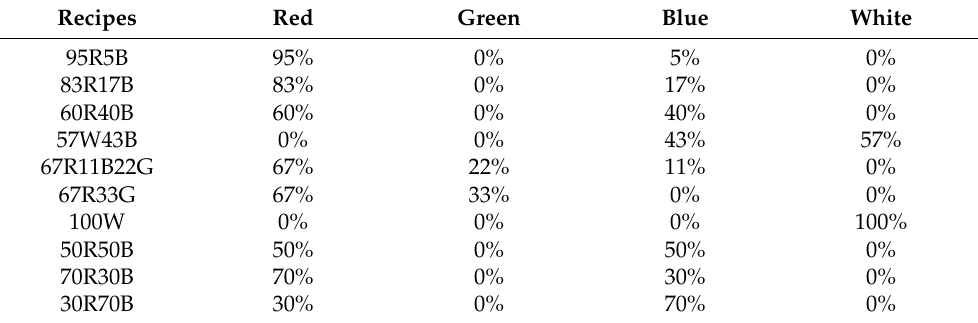
Table 2. Light treatments (recipes).